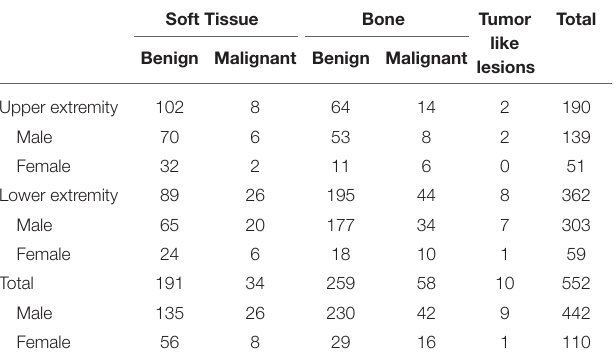
TABLE 1 | Distribution of tumors in the